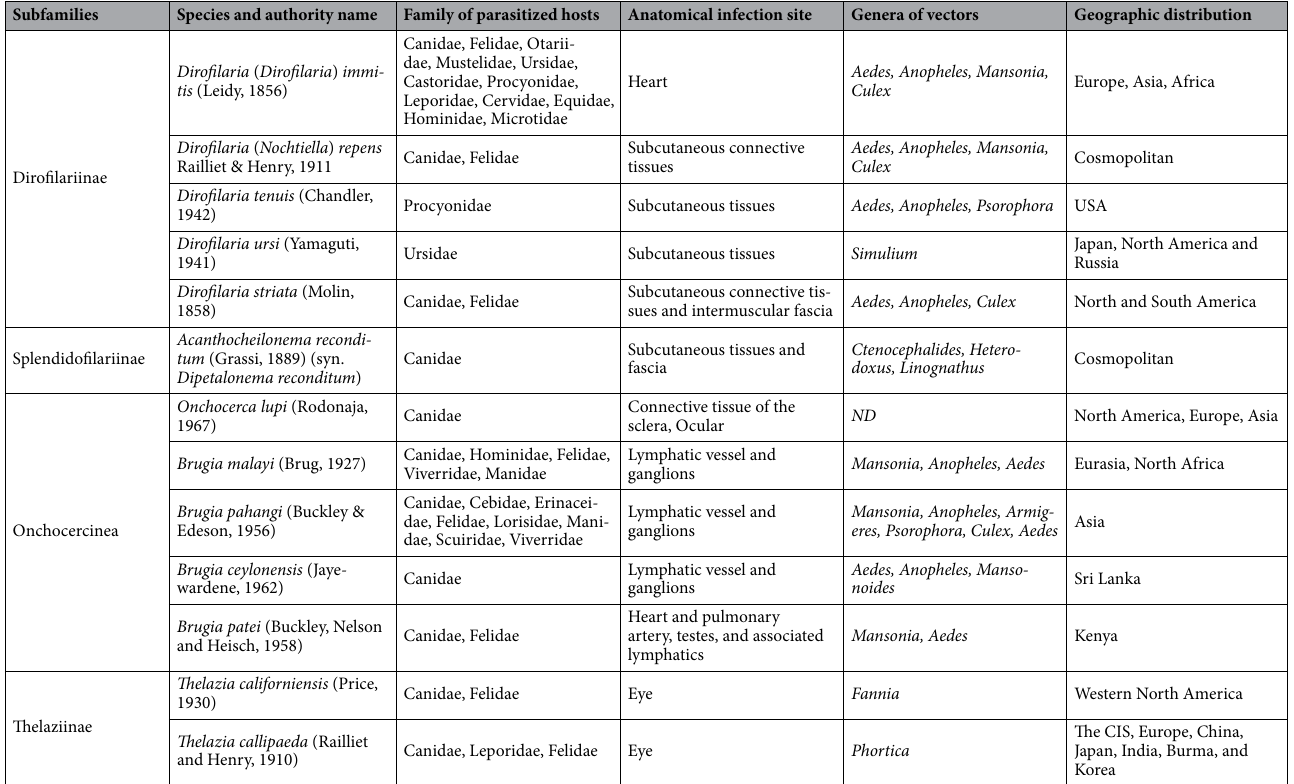
Table 1. Supplementary information of zoonotic VBH of canids 4–6,16 . Parasite subfamilies, parasitized host species, anatomical infection sites, vector genera and geographic distribution are provided. CIS: Commonwealth of Independent States which includes Armenia, Azerbaijan, Belarus, Georgia, Kazakhstan, Kyrgyzstan, Moldova, Russia, Tajikistan, Turkmenistan, Ukraine, and Uzbekistan. ND: not